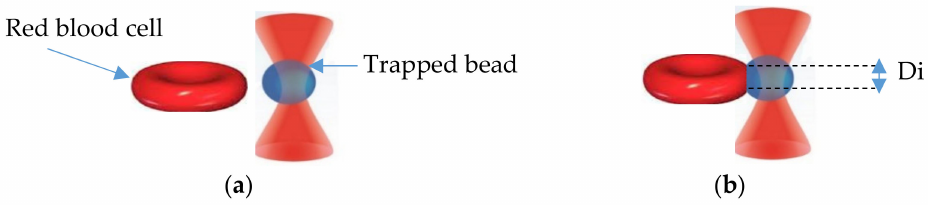
Figure 2. Interaction illustration: ( a ) no interaction; ( b ) interaction between RBC and trapped silica